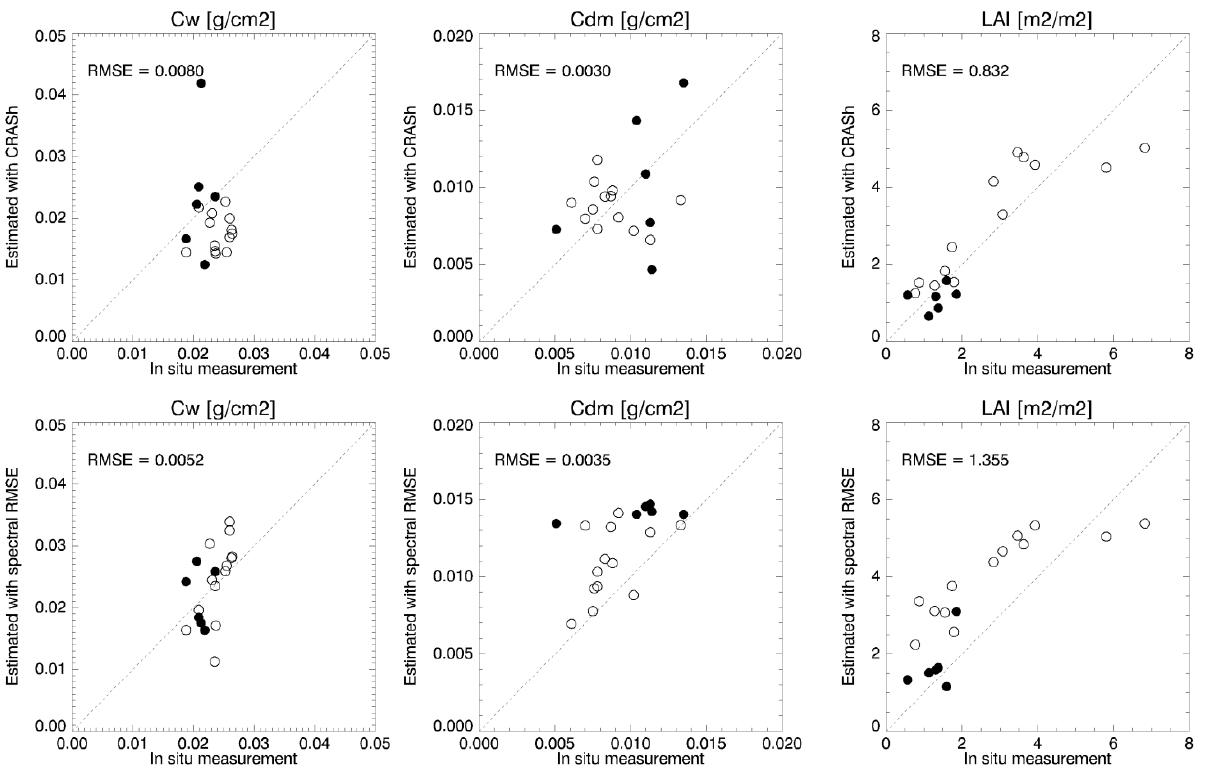
Figure 5. In situ measurements of Cw , Cdm and LAI versus estimates obtained from spectral reflectance using the CRASh approach (above) and the spectral RMSE (below). Circles refer to the measurements taken at MEA1, bullets to the measurements taken at MEA2. The dotted line indicates the 1:1